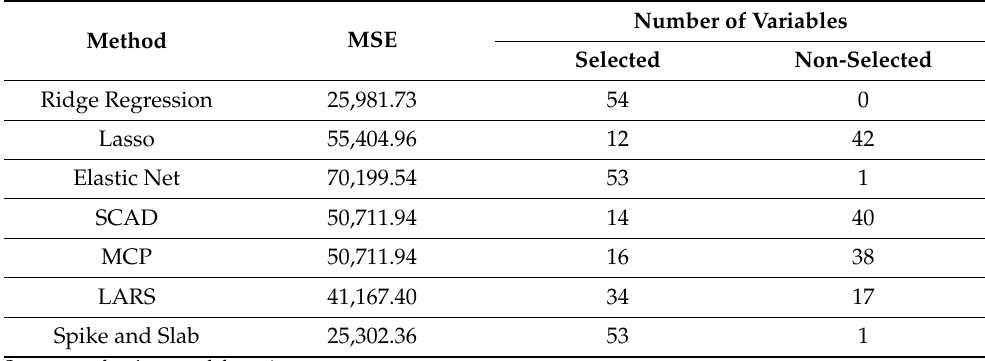
Table 1. Study of the number of optimal variables from different variable selection methods, according to the